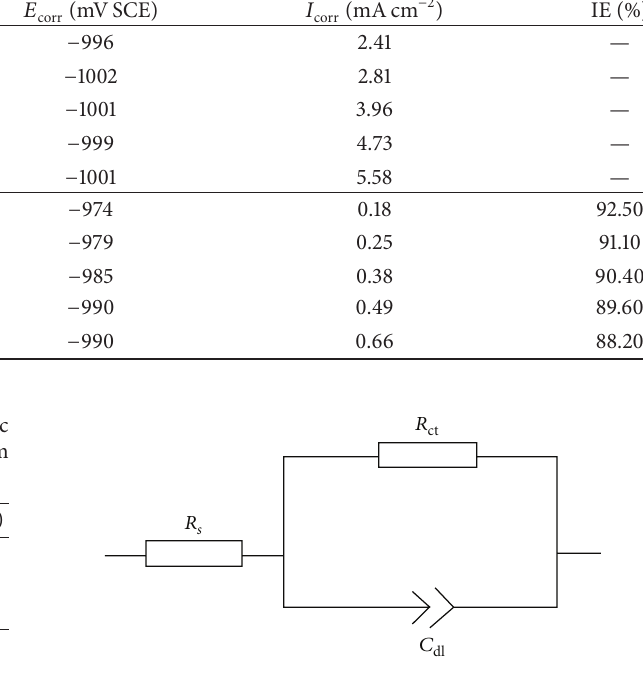
Table 6: Impedance data and surface coverage for zinc electrode in 1.0M HCl in absence and presence of different concentrations of Marjoram extract.